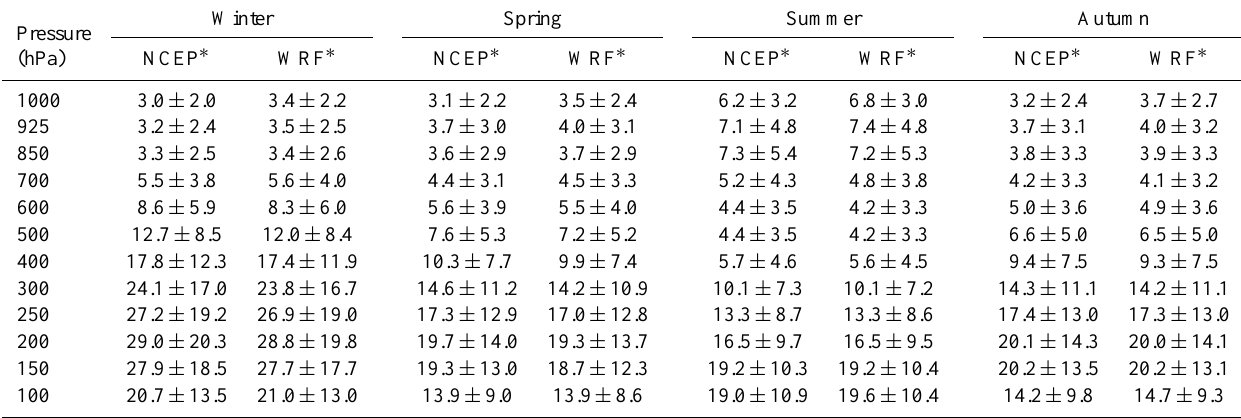
Table 5. Domain-wide average and standard deviation of zonal component of NCEP and WRF winds at different pressure levels between 1000hPa and 100hPa during winter, spring, summer and autumn of 2008.